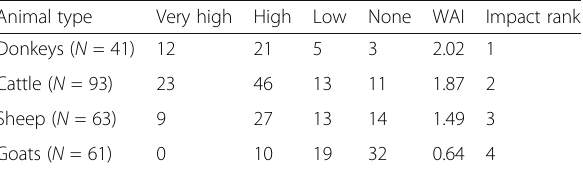
Table 1 Climate variability-related feed shortages among live- stock in the area (Source: Field Data, 2017) Animal type